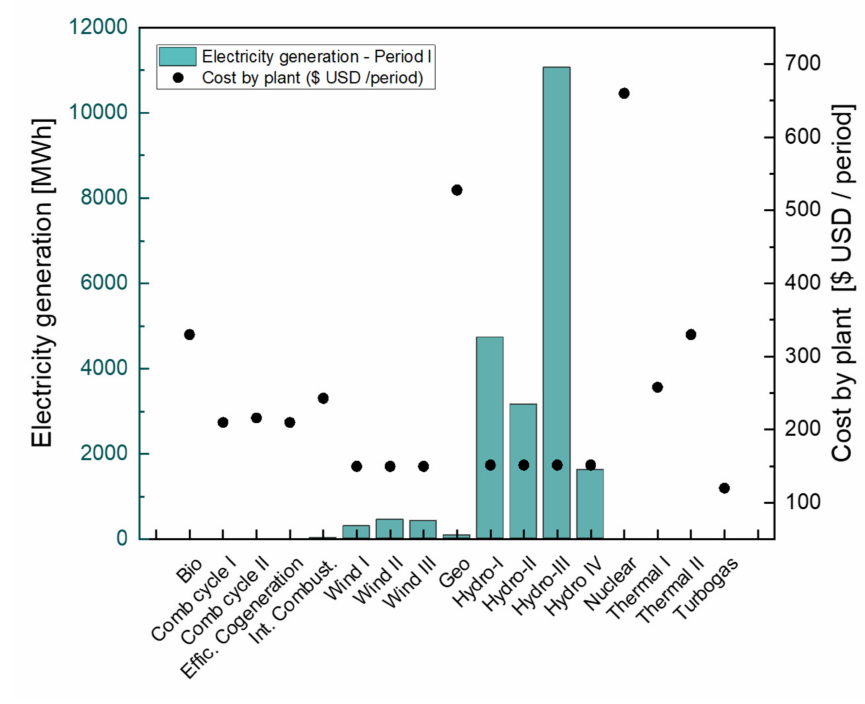
Figure 8. Electricity generation and Energy Costs for period